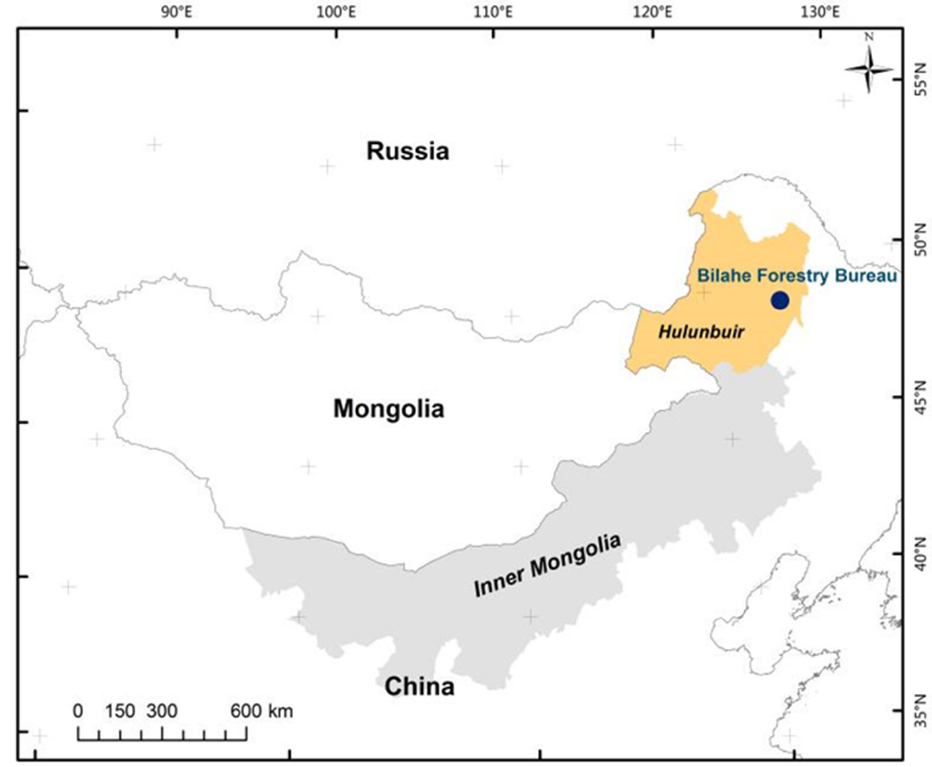
Figure 1. Map showing the location of the boreal forest study area in China where the forest fire fuel sources were sampled.